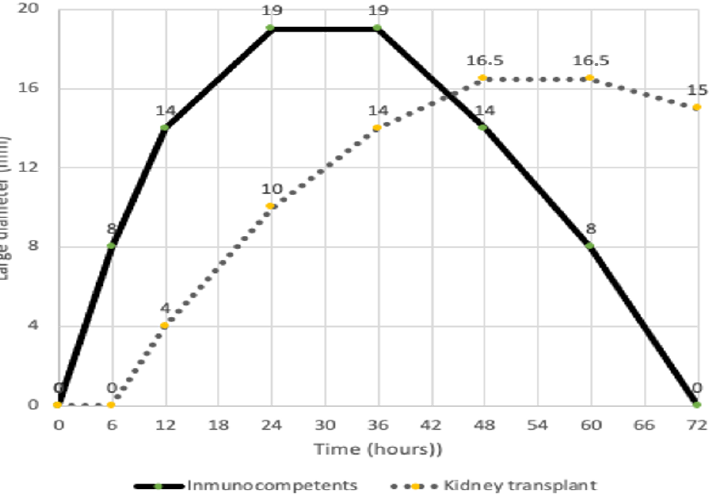
Figure 3. Kinetics of the median diameter in mm based on the cutaneous DTH response of kidney-transplanted patients (dashed line; n = 23) after intradermal test and compared with the control group of immuno-competent individuals (solid line; n =